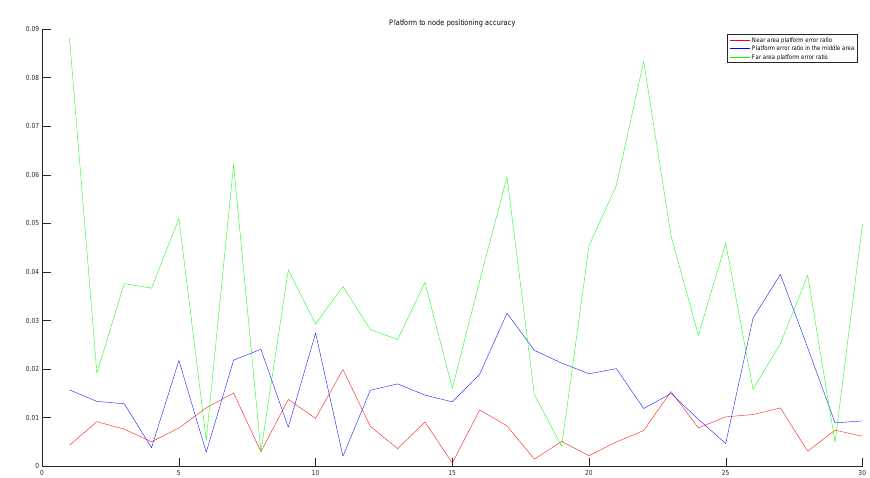
Figure 16. The platform’s error measurement of node positioning in the near, middle and far communication range.